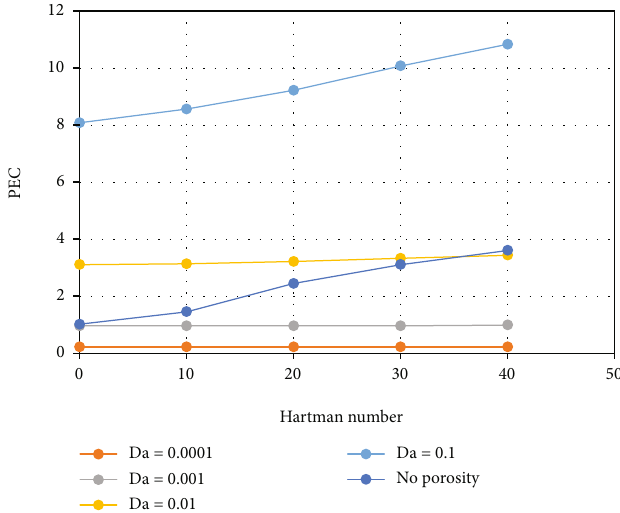
Figure 10: PEC changes against the e ff ects of magnetic fi eld and porosity using water as the base fl uid for nano fl uid